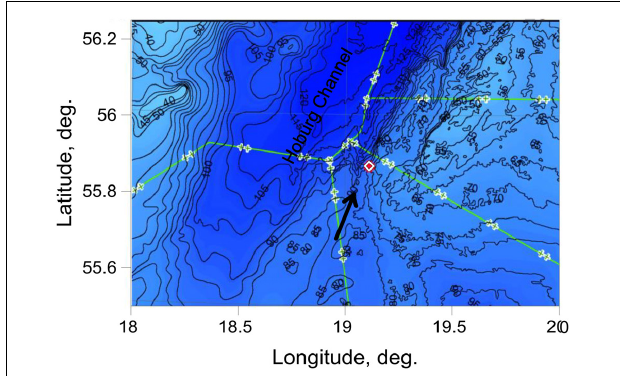
FIGURE 5 | Bottom relief and position of TCMs’ group (diamond) at the test area. Lines mark boundaries of Exclusive Economic Zones of the Baltic States. Arrow points to the